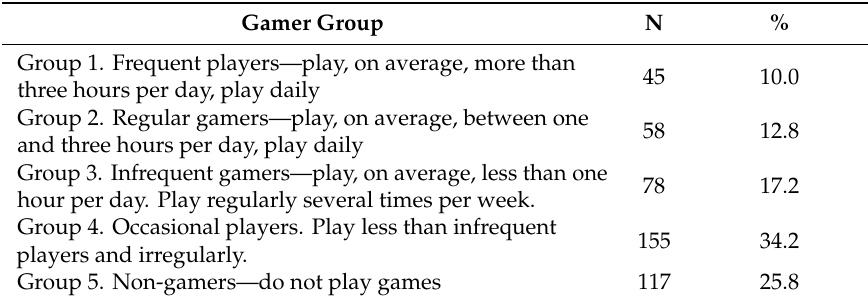
Table 1. Number of participants in each gamer